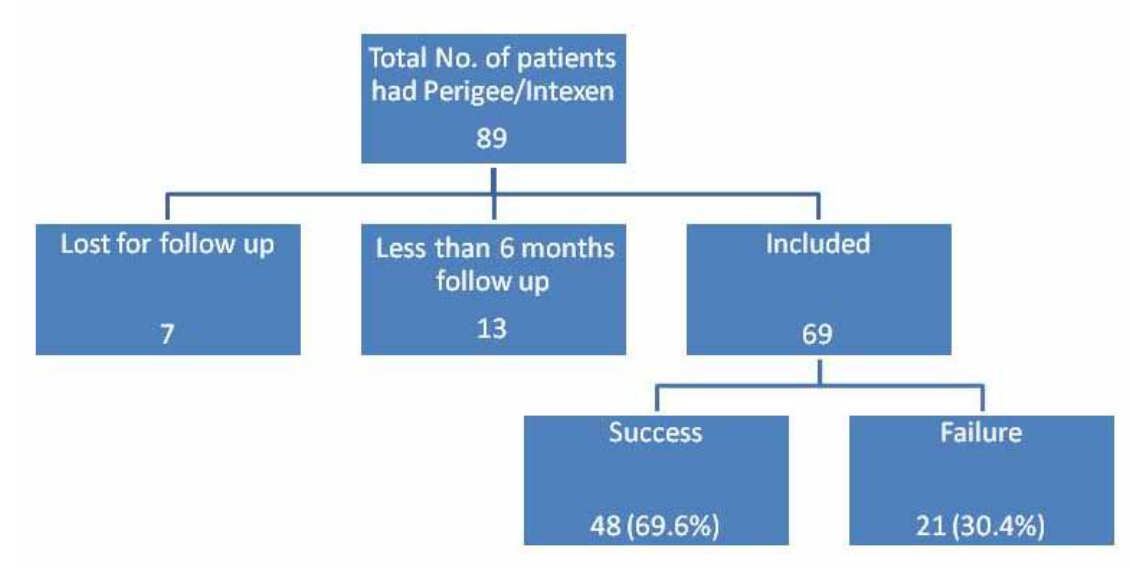
Figure 1 - Flow chart delineates the number of patients